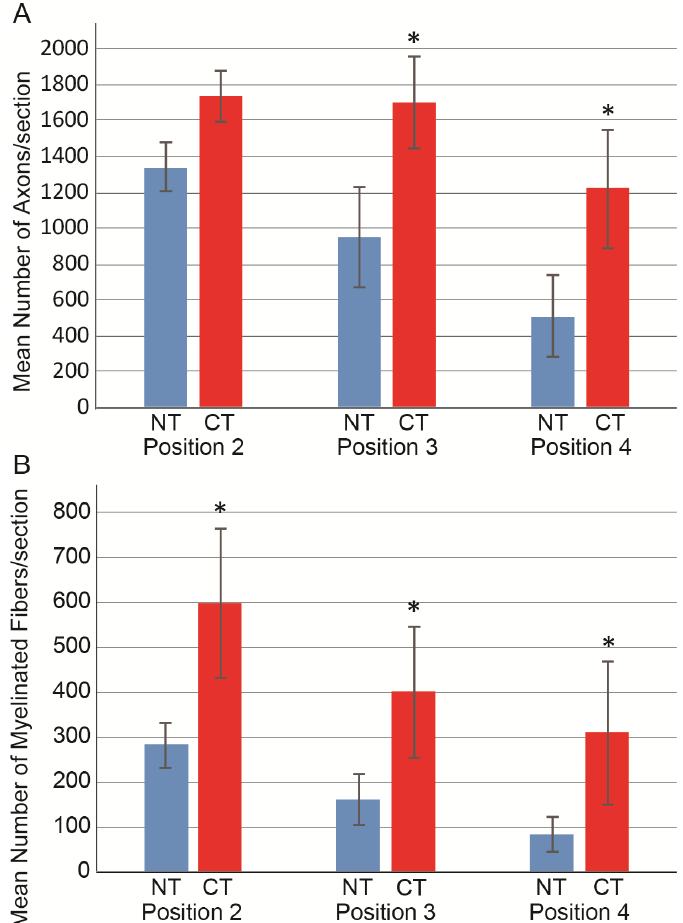
Figure 4. Number of axons and myelinated fibers in the CT ( n = 6) and NT ( n = 10) groups. ( A ) Mean number of axons/section. ( B ) Mean number of myelinated fibers/section. Values were obtained from three positions in the damaged sciatic nerve (positions 2–4, refer to Figure 1) and averaged. Values are presented as the mean ± S.E. * p < 0.05 (CT vs. NT). NT, non-cytokine administered control group; CT, cytokine administered group.